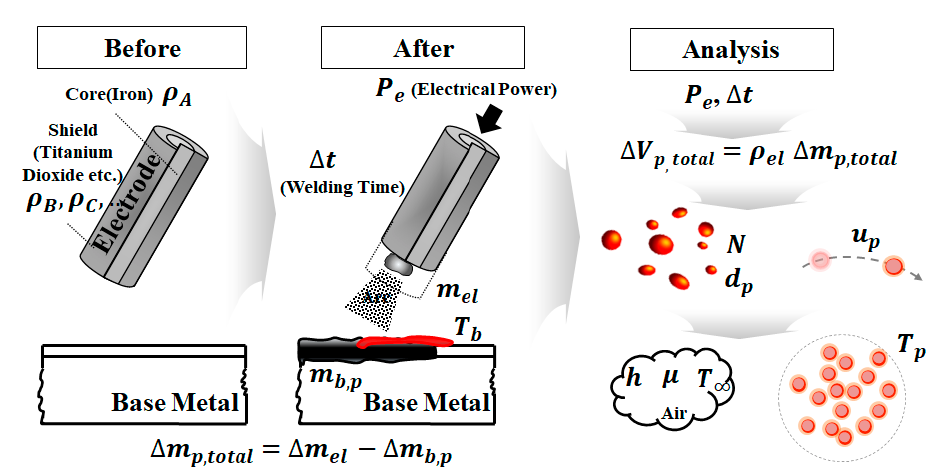
Figure 1. Schematic of welding spatter in shielded metal arc welding (SMAW) and assumptions for energy balance between particles and base metal.